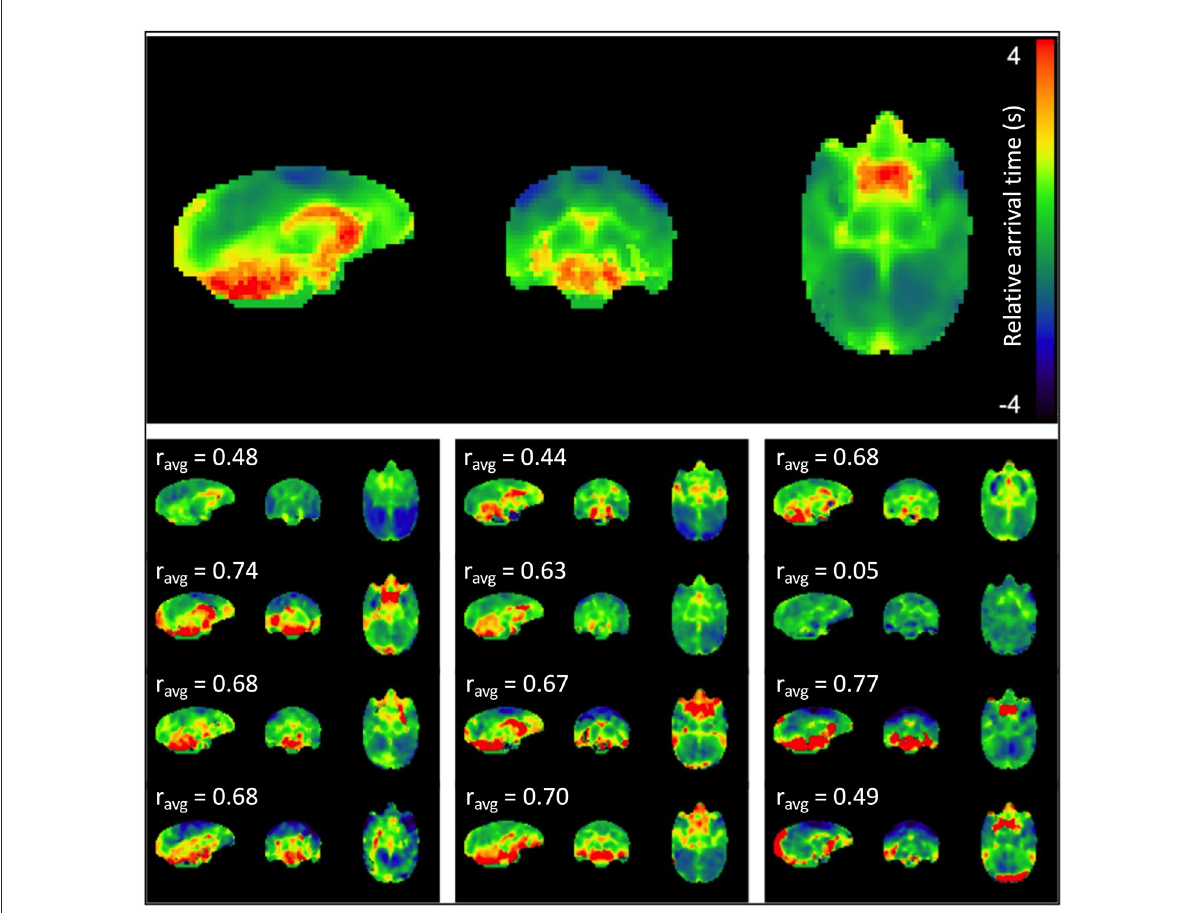
FIGURE2 sLFO arrival time maps. The mean arrival time map for the group is shown at the top, followed by subject-specific individual arrival time maps. Delays are in seconds relative to the peak of the voxelwise delay histogram. Cross-correlation between each individual map and the average map was performed, and the correlation coefficient is indicated above each individual map. The majority of the correlations (8 of 12 subjects) were moderate (0.5–0.7) to strong ( ≥ 0.7).